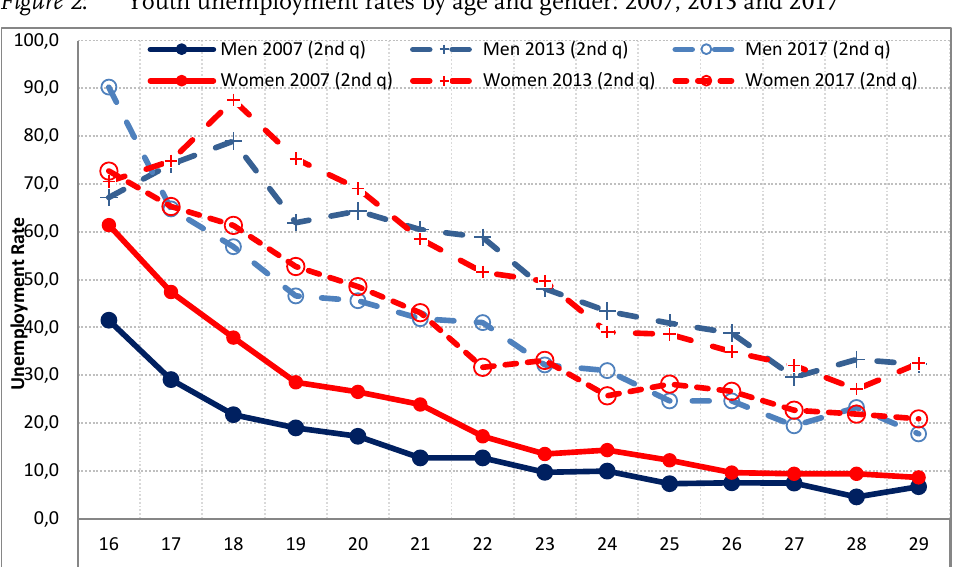
Source: Spanish Labour Force Survey (Encuesta de Población Activa, EPA), 2nd quarter, 2007, 2013 & 2017. Instituto Nacional de Estadística